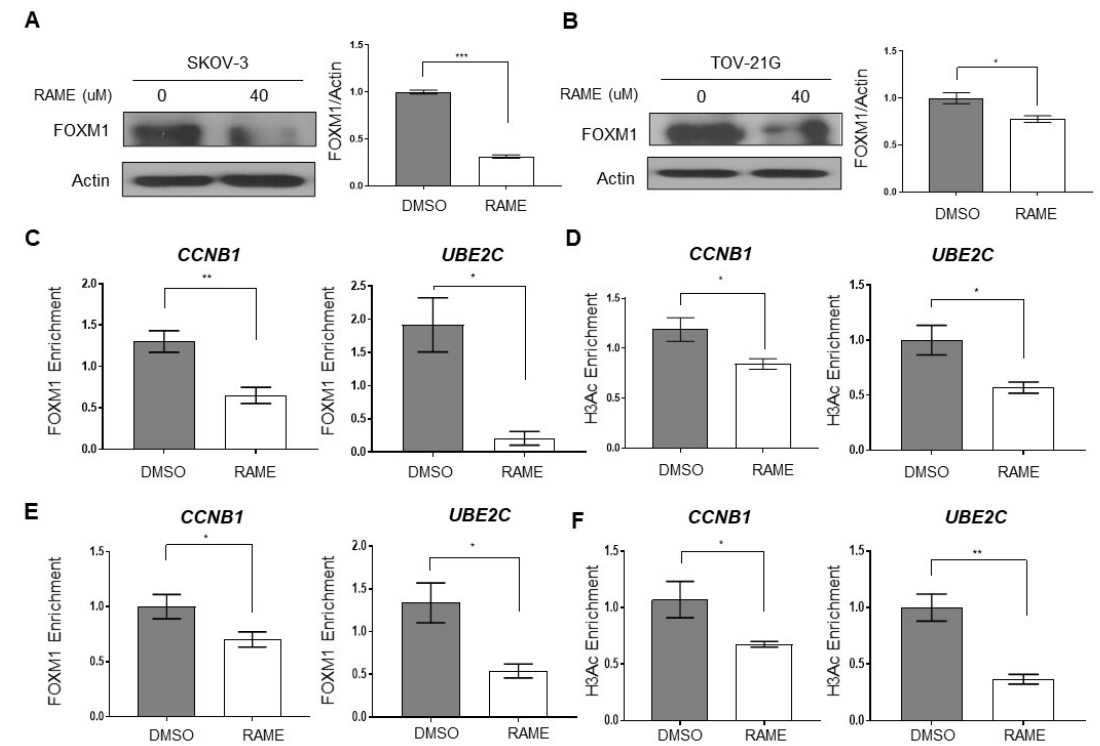
Figure 2. RAME decreases FOXM1 levels and the expression of its target genes by inhibiting the enrichment of FOXM1 on promoters. ( A ) Immunoblot analysis of FOXM1 (left) and its quantitative graph (right) in SKOV-3 cells. ( B ) Immunoblot analysis of FOXM1 (left) and its quantitative graph (right) in TOV-21G cells. ( C , D ) Chromatin Immunoprecipitation (ChIP)-qPCR analysis with FOXM1 ( C ) and H3Ac ( D ) antibody on CCNB1 and UBE2C promoters in RAME-treated SKOV-3 cells treated with 40 µ M of RAME for 24 h. ( E , F ) Chromatin Immunoprecipitation (ChIP)-qPCR analysis with FOXM1 ( E ) and H3Ac ( F ) antibody on CCNB1 and UBE2C promoters in RAME-treated TOV-21G cells treated with 40 µ M of RAME for 24 h. Error bars represent the mean ± SEM ( n = 3). * p < 0.05, ** p < 0.01, *** p < 0.001; unpaired t -test.